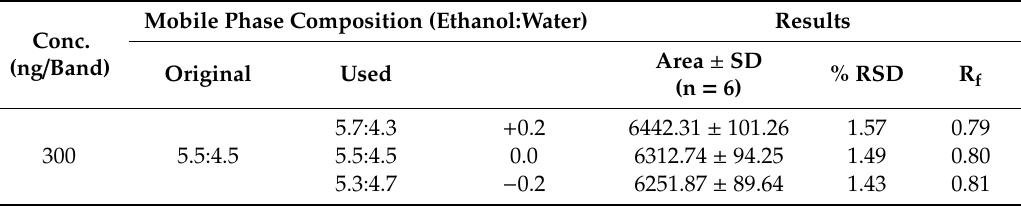
Table 5. Robustness of HPTLC method (mean ± SD; n = 6).